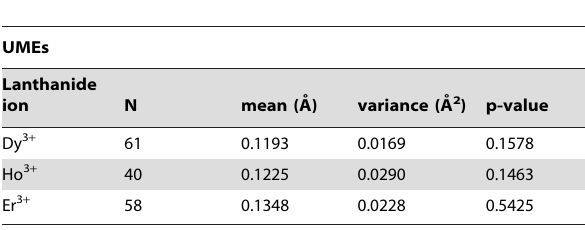
Table 6. Means and variances for the c distribution fits for the UMEs computed for the N complexes for each lanthanide trication.